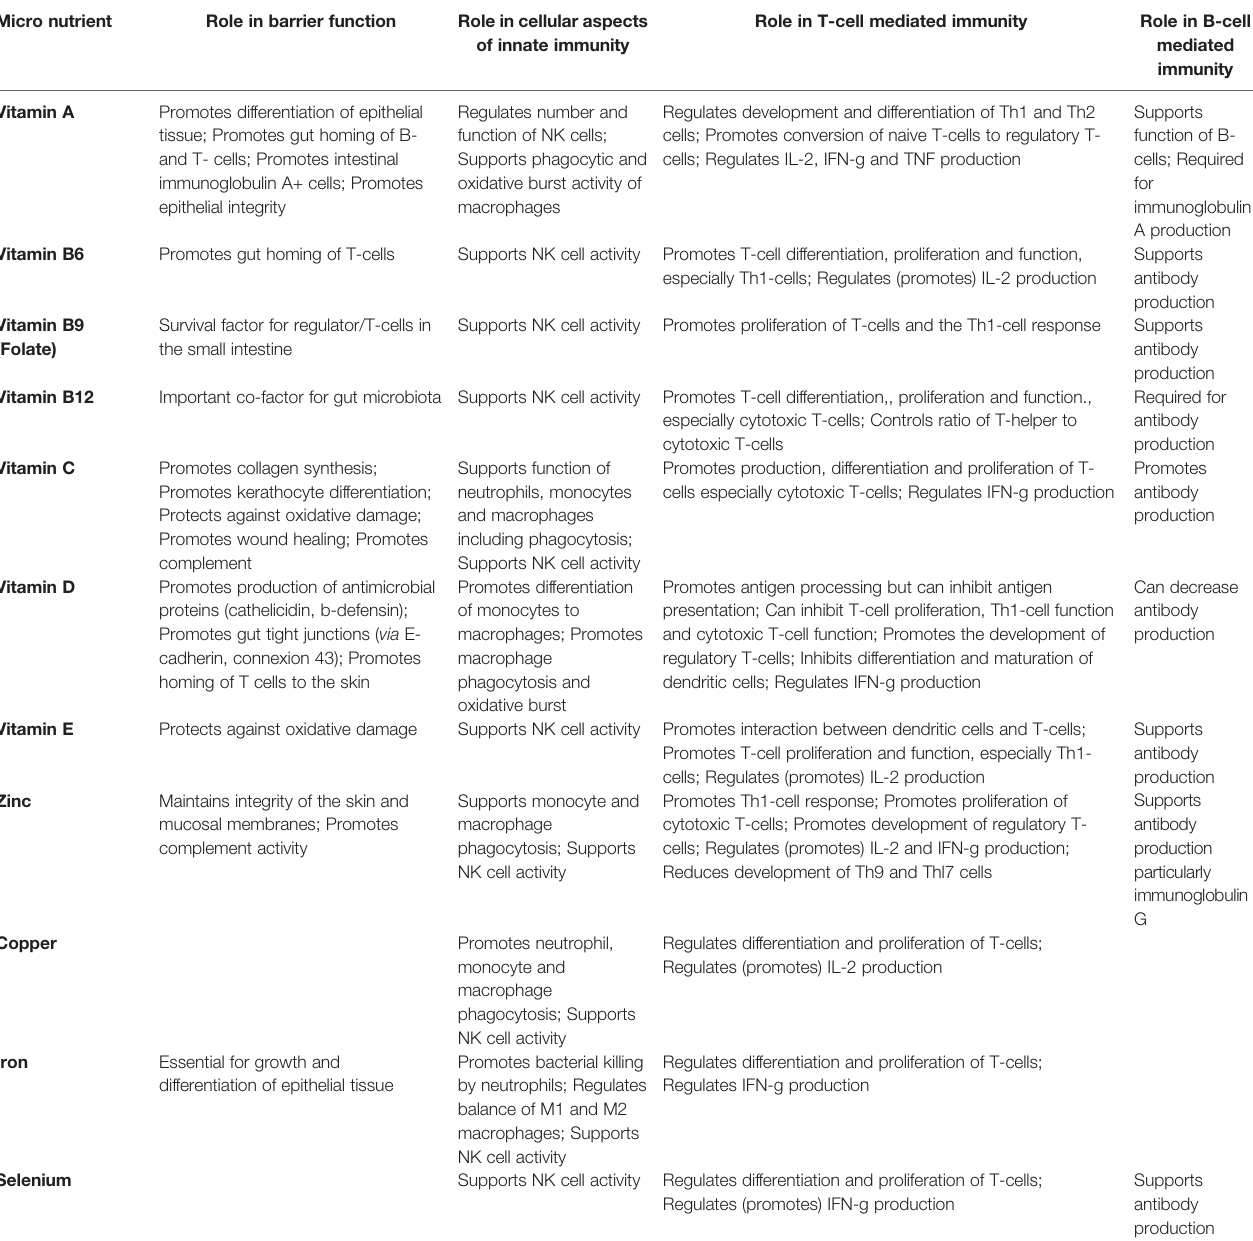
TABLE 1 | Taken from (58). Summary of the effects of various micronutrients on different aspects of immunity. Micro